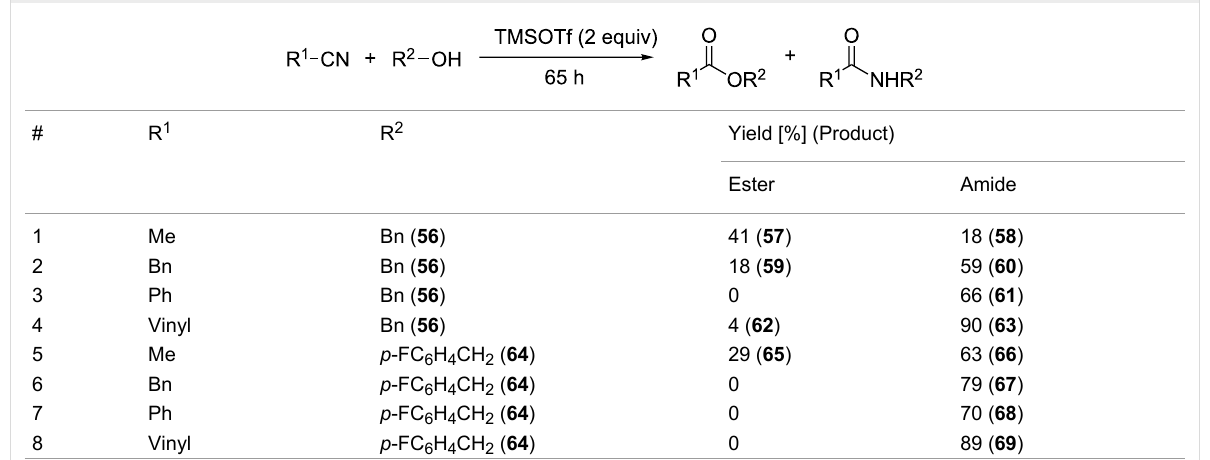
Table 3: Carboxamide formation in a Pinner-type reaction. a